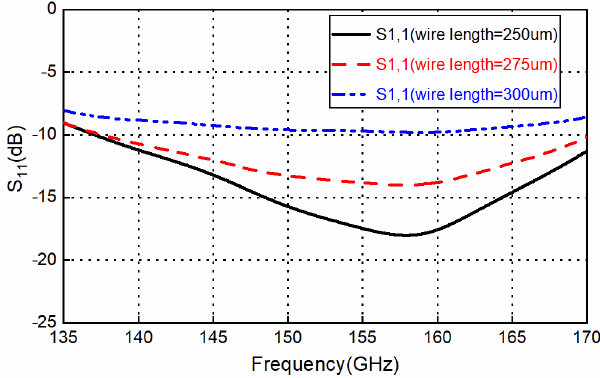
Figure 9. Effect of the slot length (slot_L ) on the designed transition frequency response.